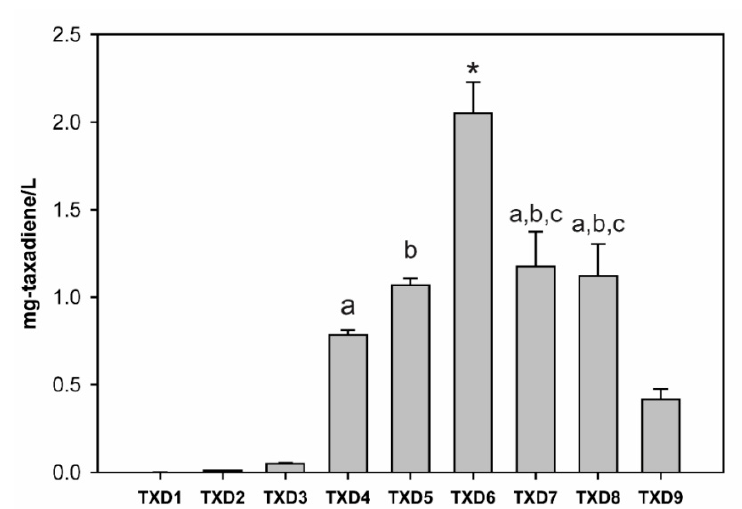
Figure 4. Taxadiene titers from the constructed yeast strains (Table 1). The asterisk shows significant differences ( p -value < 0.01) on taxadiene titer of TXD6 with other strains. The alphabet ‘a, b, and c’ show no significant differences ( p -value > 0.05) between the data with same alphabet (e.g., no significant differences between TXD4 and TXD7; and no significant differences between TXD4 and TXD8). Other data without symbol or alphabet have significant differences with other data with p -values at least less than 0.05 (most of them has p -values < 0.01).